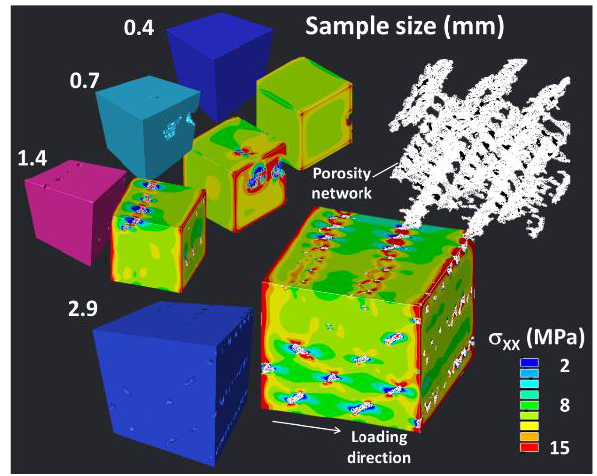
Figure 14. E ff ect of sample size on the stress component σ XX distribution (voxel size is fixed to 14.31 µ m, Figure 14. Effect of sample size on the stress component  XX distribution (voxel size is fixed to 14.31 X is the loading µm, X is the loading direction).